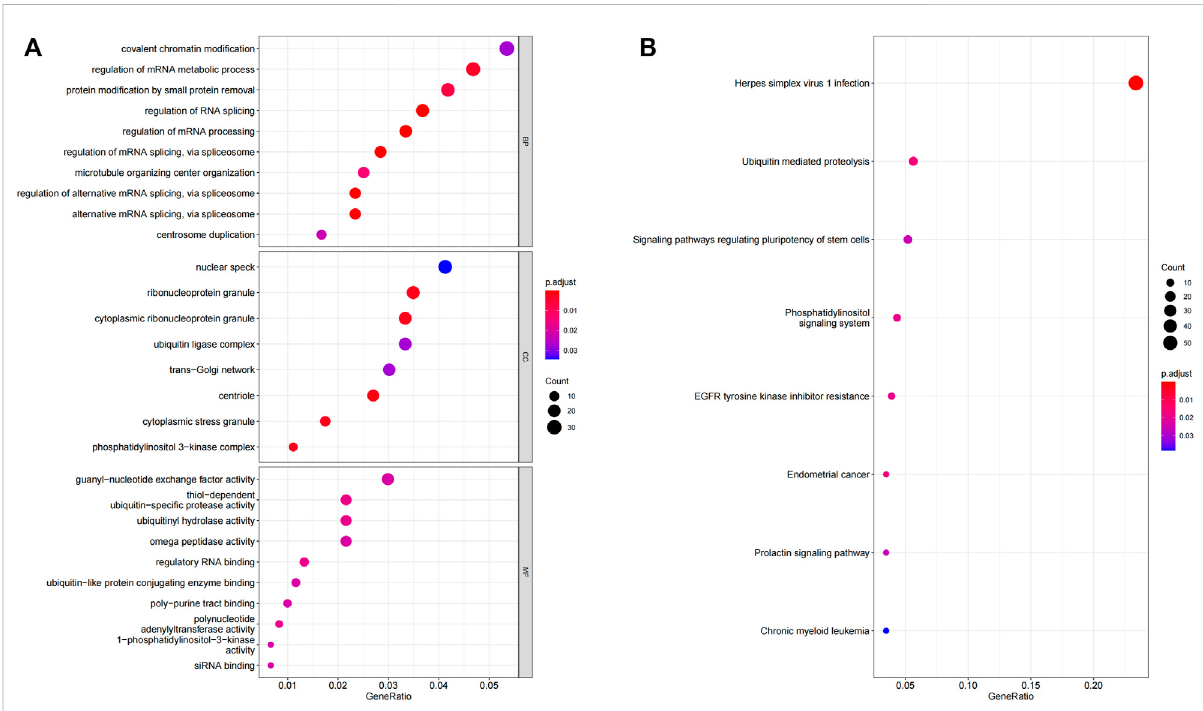
FIGURE 8 GO and KEGG functional enrichment analysis of the mRNA co-expressed with 5 OS-related lncRNA. (A) GO enrichment analysis. (B) KEGG enrichment